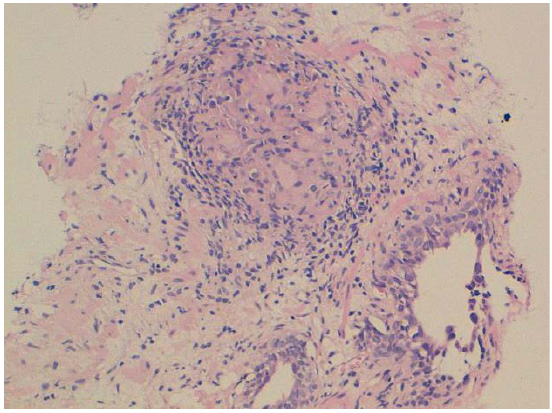
1: Histology of granulomatous infection with caseous necrosis and giant cells in prostatic parenchyma. Prostatic tuberculosis may cause transient elevation of PSA levels that decreases with resolution of in fl ammation [12]. In our case, serum PSA came down to